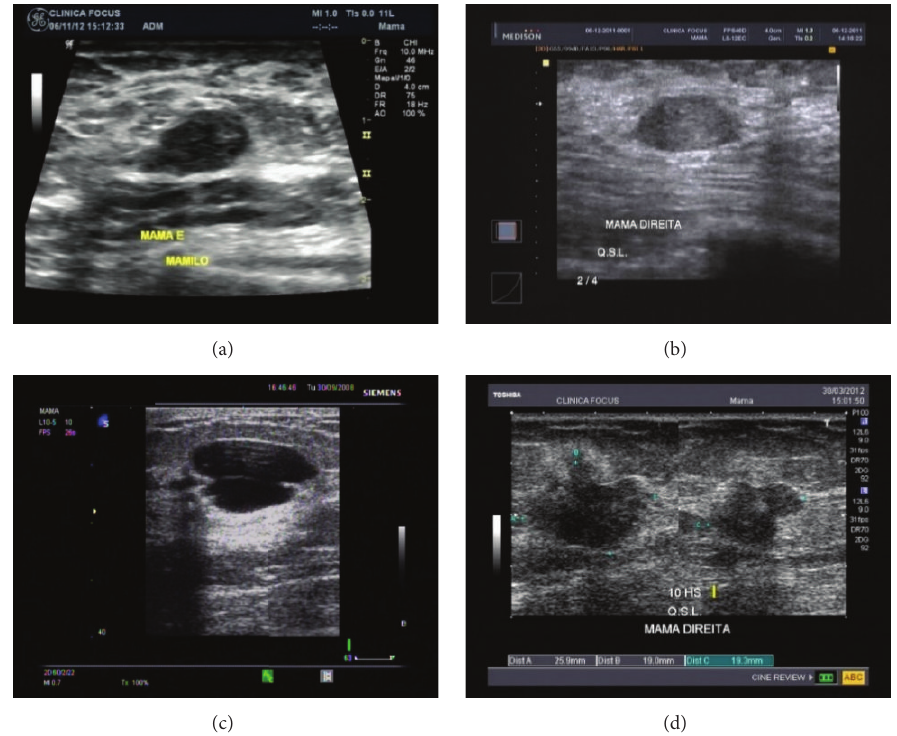
Figure 3: Breast clinical B-mode image acquired from (a) General Electric Logiq P5, (b) Medison X8, (c) Siemens G50, and (d) Toshiba Nemio